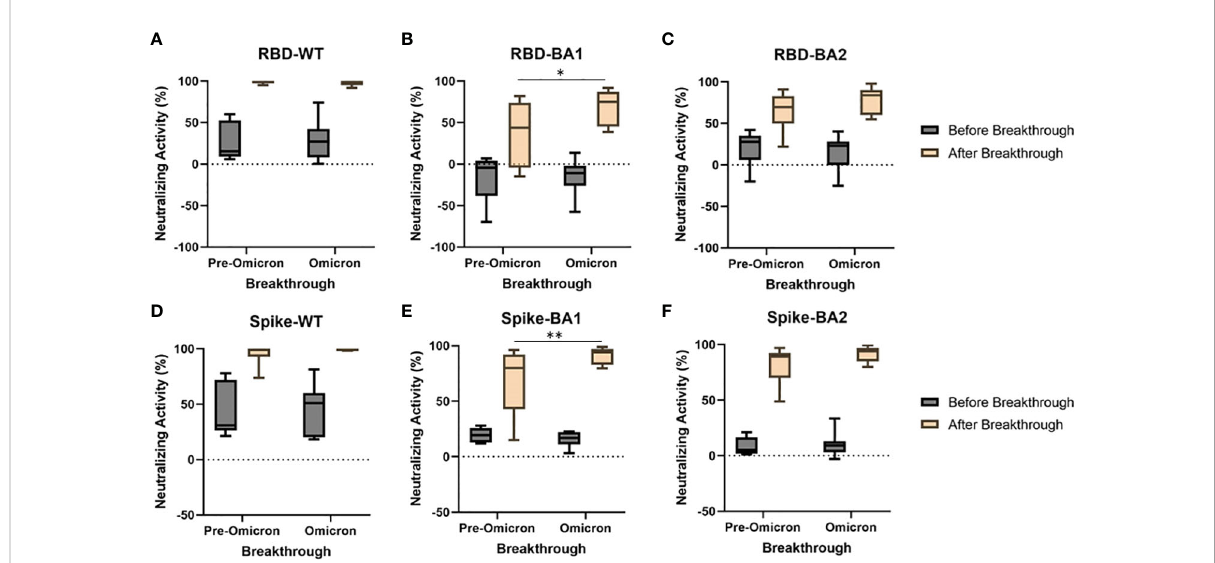
FIGURE 3 A subset of vaccinated individuals experienced breakthrough infections during the study. Breakthrough infections were separated into those likely to be pre-omicron (symptom onset before Dec 5, 2021, N=6) and those likely to be omicron (symptom onset after Dec 30, 2021, N=11). Breakthroughs occurring during both eras produced near maximal increases in WT Nabs using RBD (A) and spike (D) . Increases in Nabs to BA1 (B, E) , but not BA2 (C, F) were signi fi cantly greater when the breakthrough occurred in the omicron era compared to when the breakthrough occurred pre-omicron for both RBD (p<0.05) and spike (p<0.01). *p<0.05,